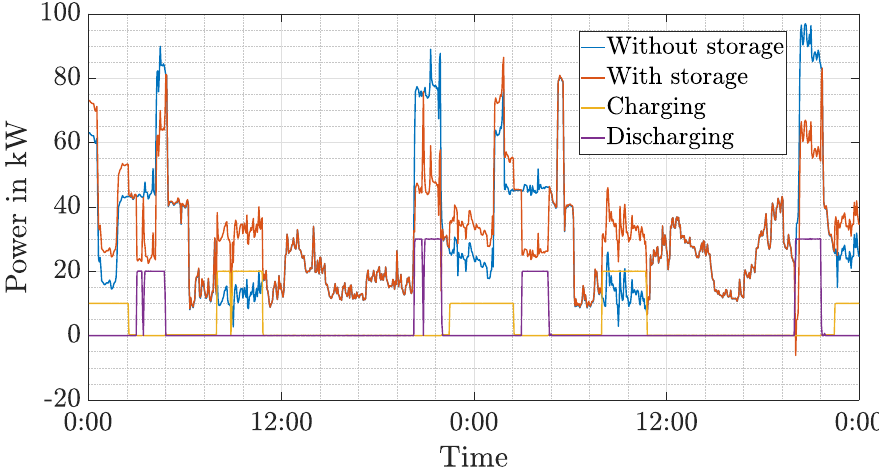
Figure 11. Results after recalculate time shift for the fixed schedule strategy.